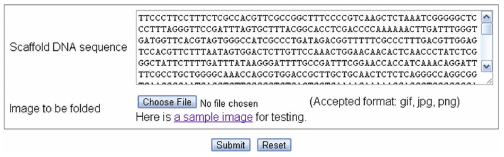
Figure 1: Screenshot from FOLDNA home page. In the web server FOLDNA, users can upload a monochrome image and a sca ff old DNA sequence. Then the server will automatically design the whole nanostructure. Here we have a default sca ff old DNA sequence (M13mp18) provided. It can be customized to any desired